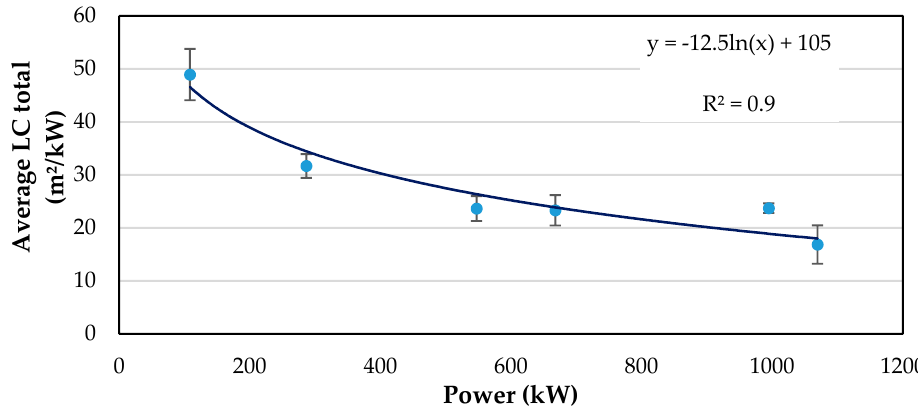
Figure 8. Relation between installed power and average total LC (m 2 /kW).